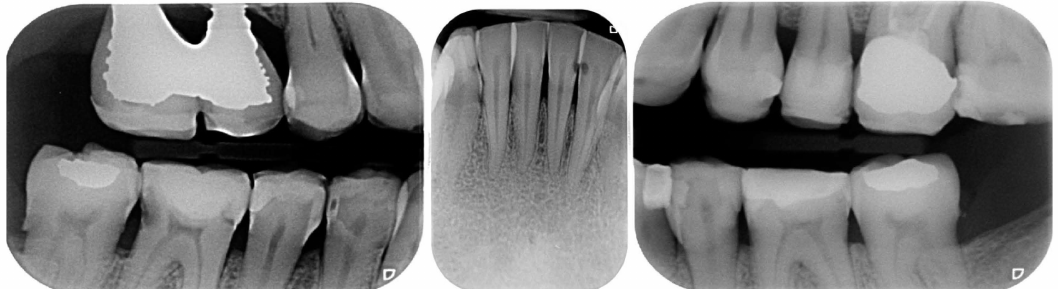
Figure 5. Pre-treatment evaluations by endoral radiographs.